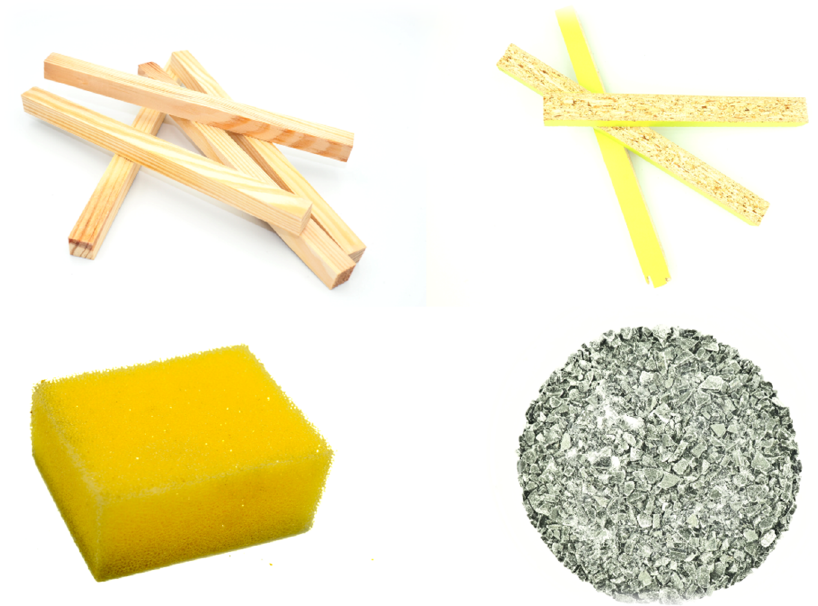
Figure 1. Four materials used in the experiment. The pinewood scantlings (PINE, upper left), laminated particleboard (LPB, upper right), fragment of PUR foam sheet (lower left), granules of PMMA (lower right).